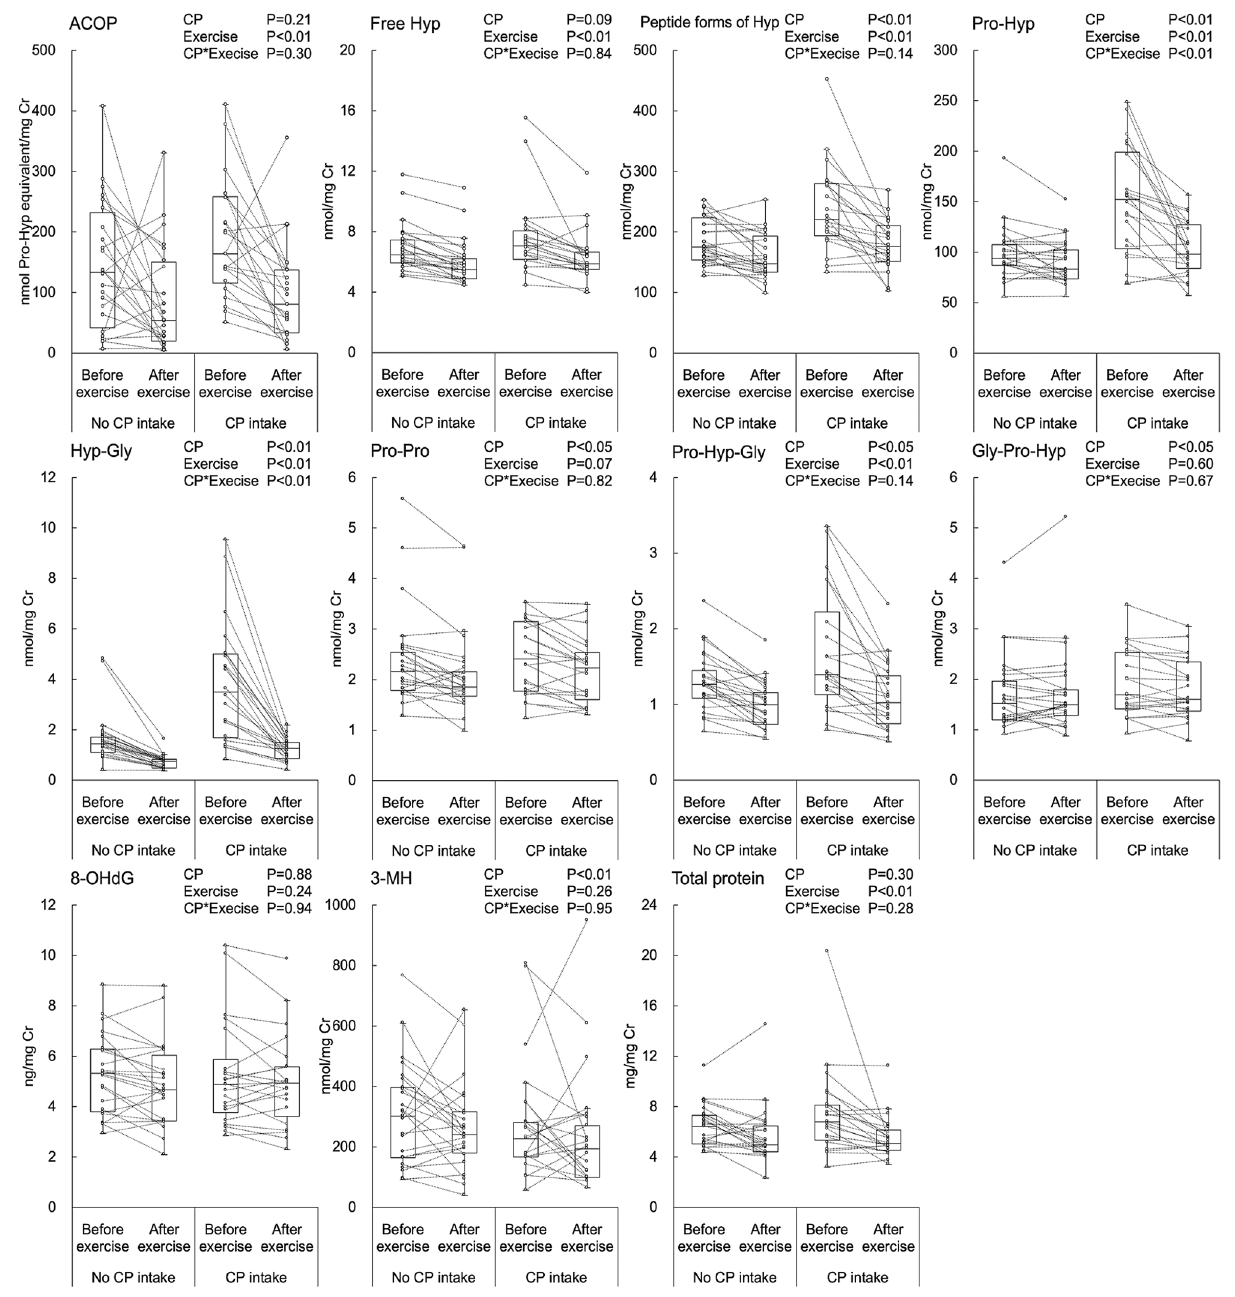
Figure 3. Effect of physical activity on urinary collagen-derived metabolites. Boxplots indicate the median, interquartile range, maximum–minimum whiskers, and outliers. Circles and dotted lines indicate differences between values measured before and after exercise in athletes who did (n = 22, CP intake) and did not (n = 24, No CP intake) routinely take CP supplements. Each sample were measured using colorimetry for free Hyp, peptide forms of Hyp and total protein; LC–MS/MS for Pro-Hyp, Hyp-Gly, Pro-Pro, Pro-Hyp-Gly, Gly-Pro- Hyp, 8-hydroxy-2 ′ -deoxyguanosine (8-OHdG), and 3-methylhistidine (3-MH); and ELISA for ACOP. Two- way analysis of variance (upper right corner of each graph) shows the effect of routine CP intake and physical activity (Exercise). P < 0.05 was considered statistically